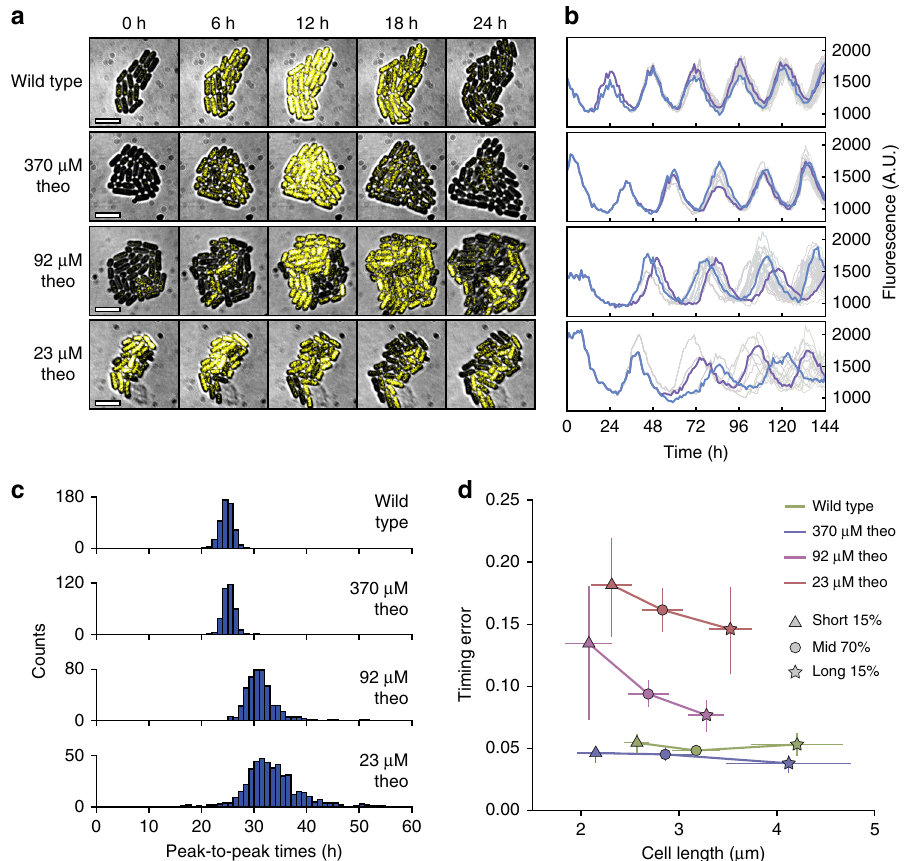
Fig. 2 Single cell microscopy reveals desynchronized oscillations at low Kai copy number. a Filmstrips of YFP oscillations in wild-type cells and the copy number tunable strain induced with 1 μ M IPTG and various theophylline concentrations (bright fi eld and YFP fl uorescence overlaid). Scale bar: 5 μ m. b Single cell oscillator trajectories (gray) with two example cell lineages highlighted (blue and purple). c Distributions of peak-to-peak times in wild-type and copy number tunable cells; n = 536 (wildtype), 336 (370 μ M), 455 (92 μ M), 616 (23 μ M). d Cell length vs. timing error (standard deviation/mean of peak-to-peak intervals) in the 15% shortest cells (triangles), middle 70% cells (circles), and 15% longest cells (stars) for each condition. Vertical error bars indicate 95% con fi dence intervals from bootstrapping (5000 iterations), and horizontal error bars indicate standard deviation in cell